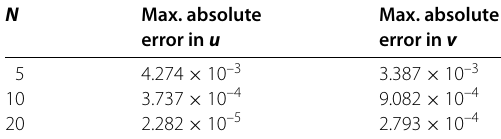
Table 3 Maximum absolute error for Example 2